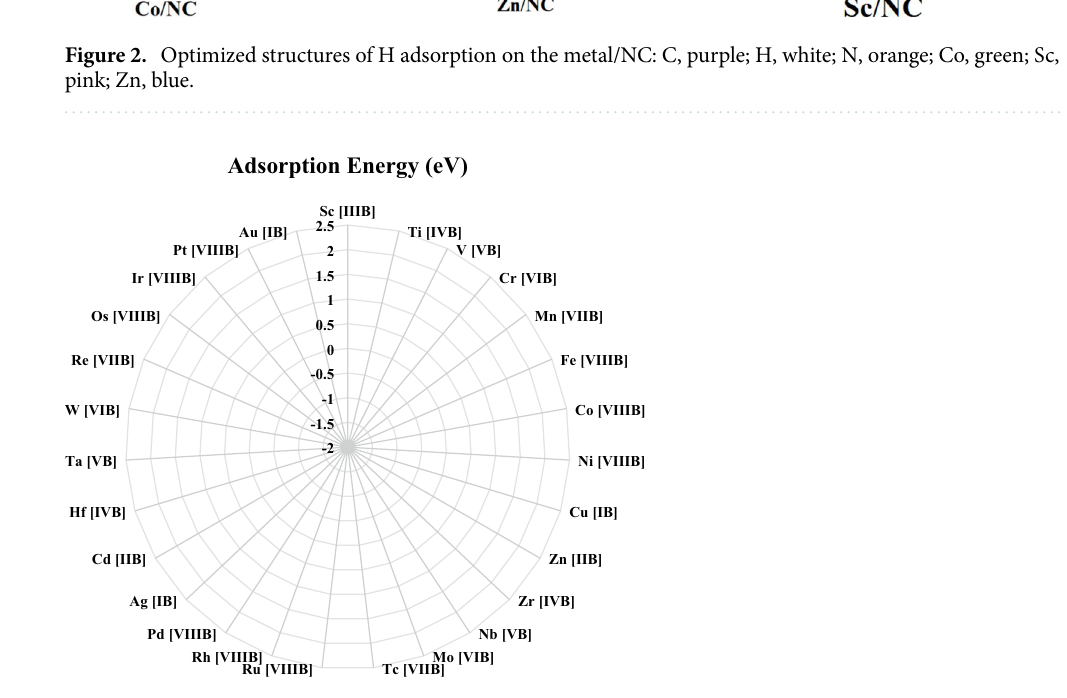
Figure 3. Comparison of hydrogen adsorption energy different metal/NC